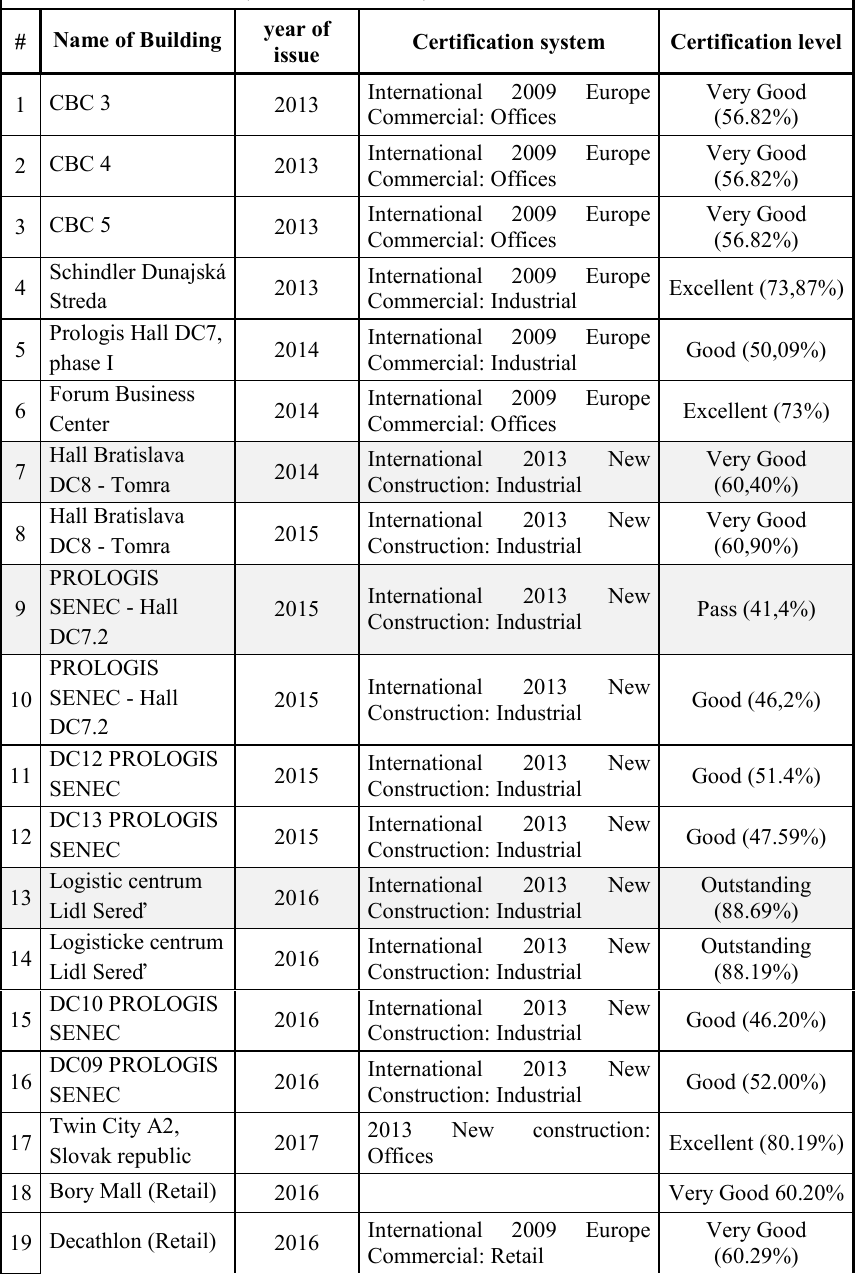
Table 2. BREEAM Certification (New Construction) in Slovakia [5],